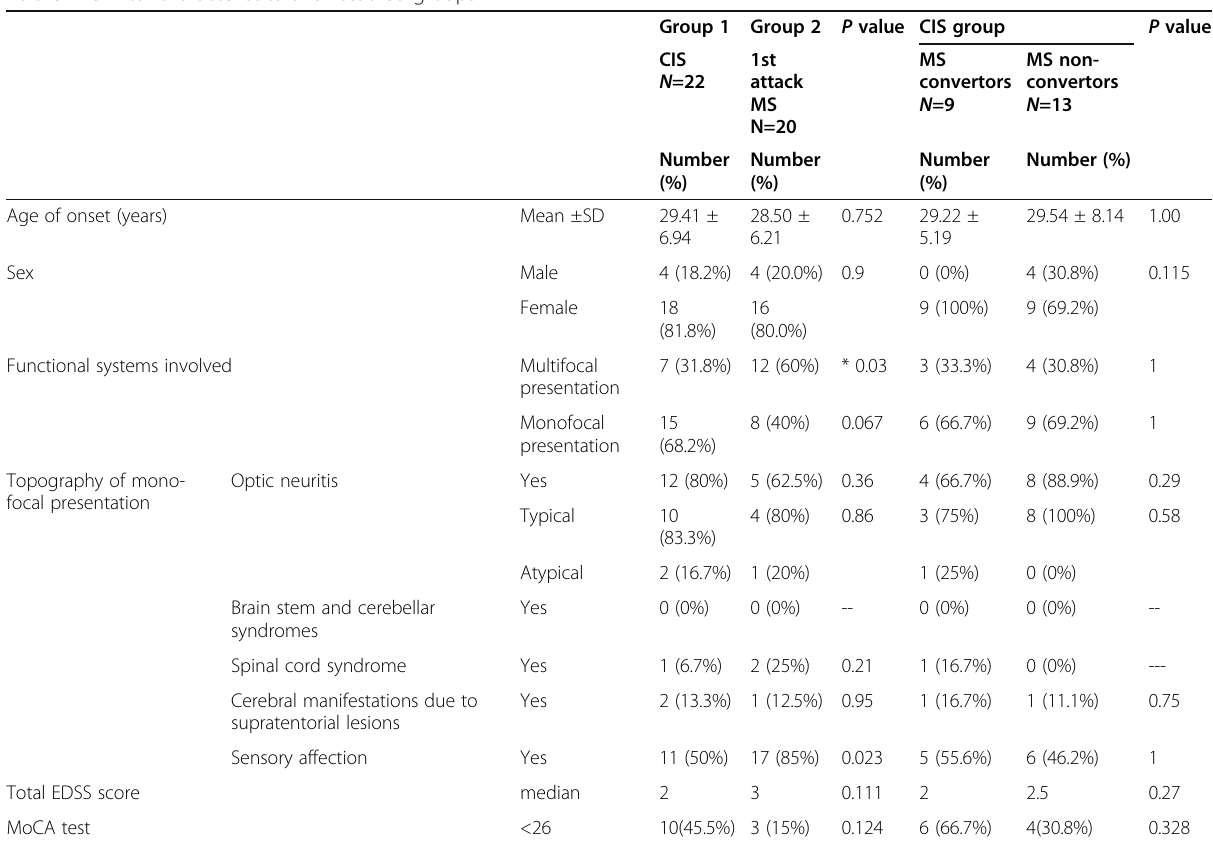
Table 1 Clinical characteristics of all studied groups